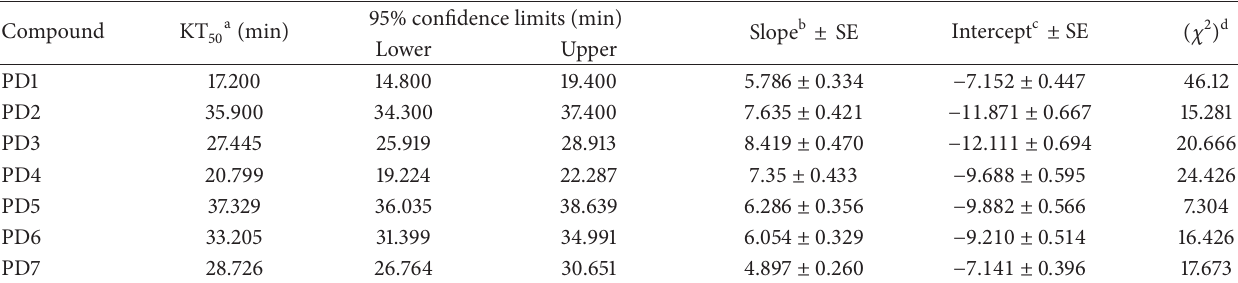
Table 2: Knockdown time (KT 50 ) of different monoterpenes loaded on paper discs against female adult Cx. pipiens . Compound KT 50 a (min) Lower Upper PD1 17.200 PD2